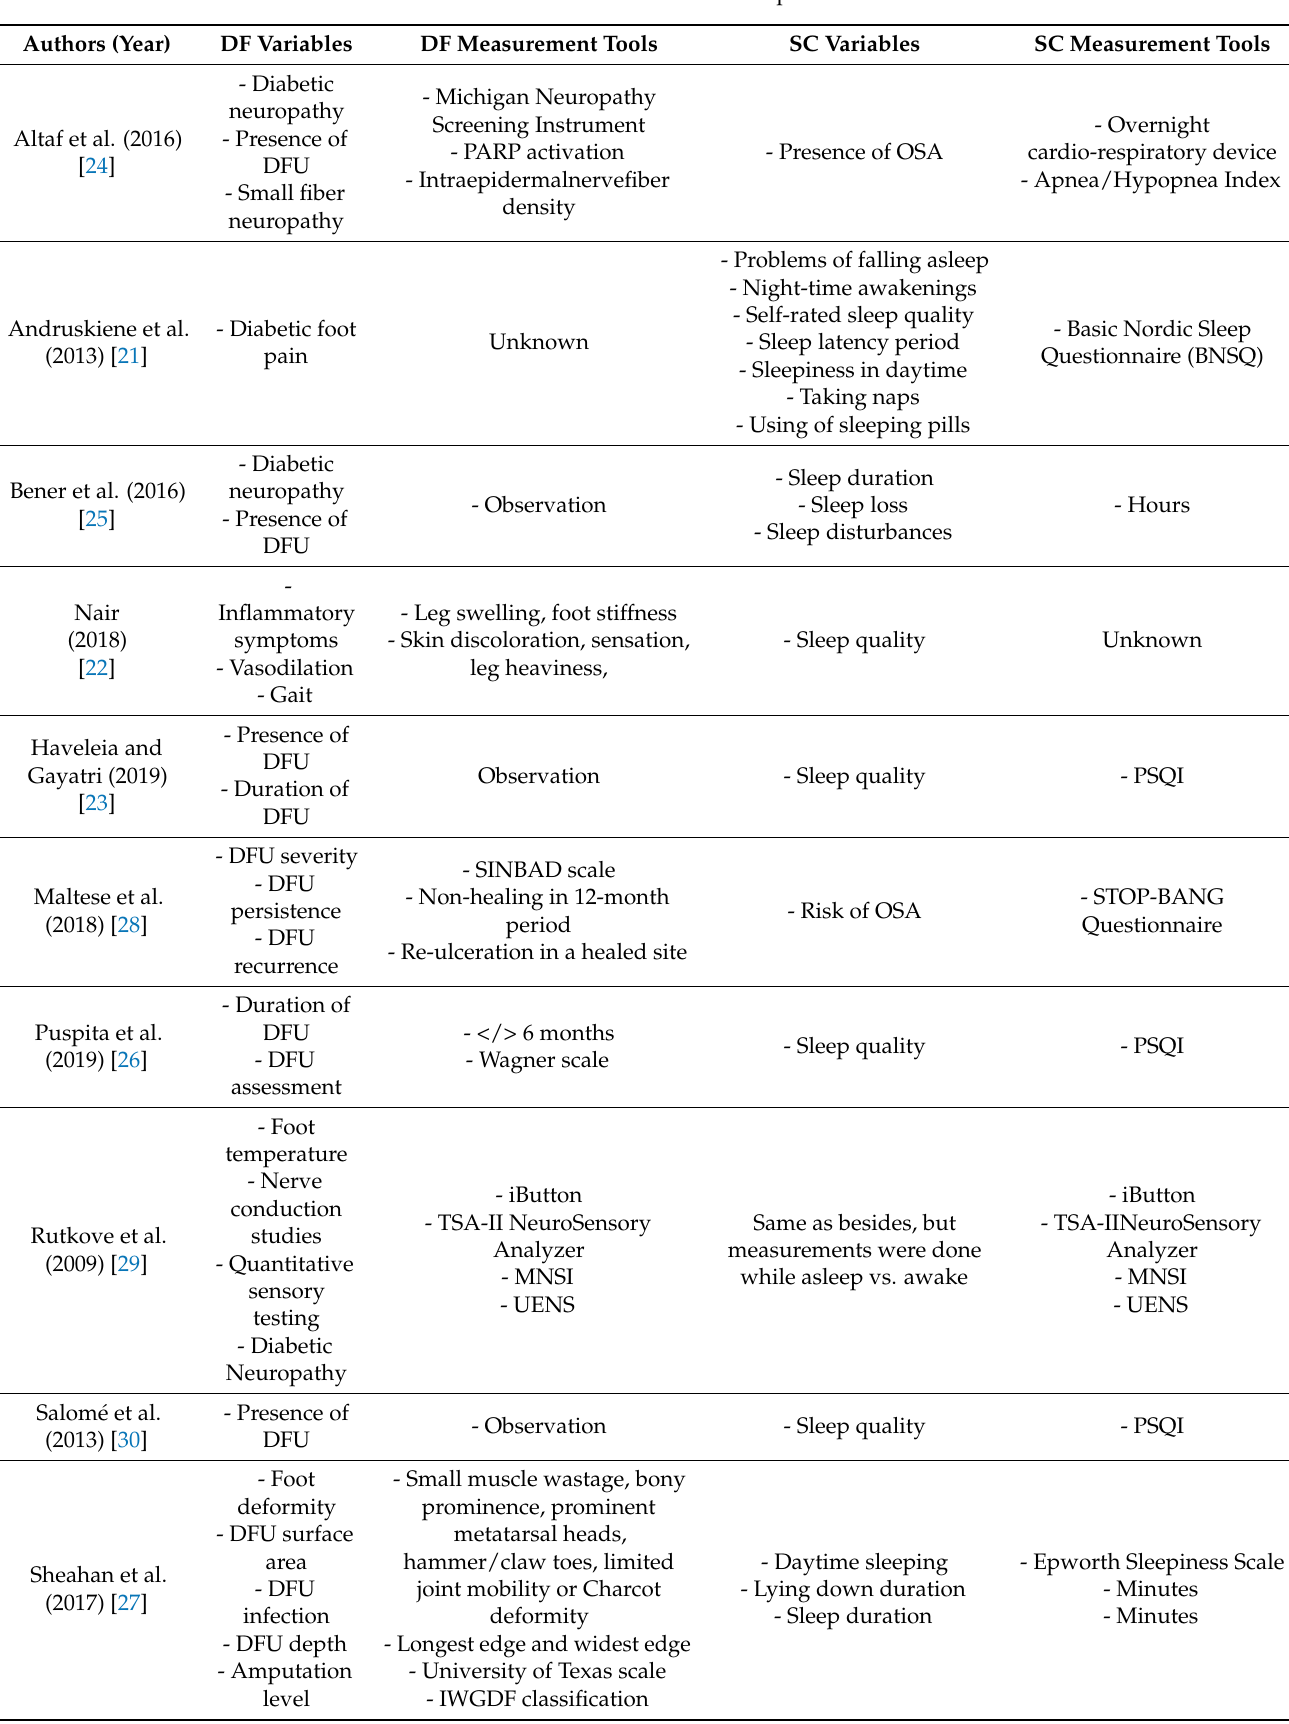
Table 2. Outcome variables related to the sleep and diabetic